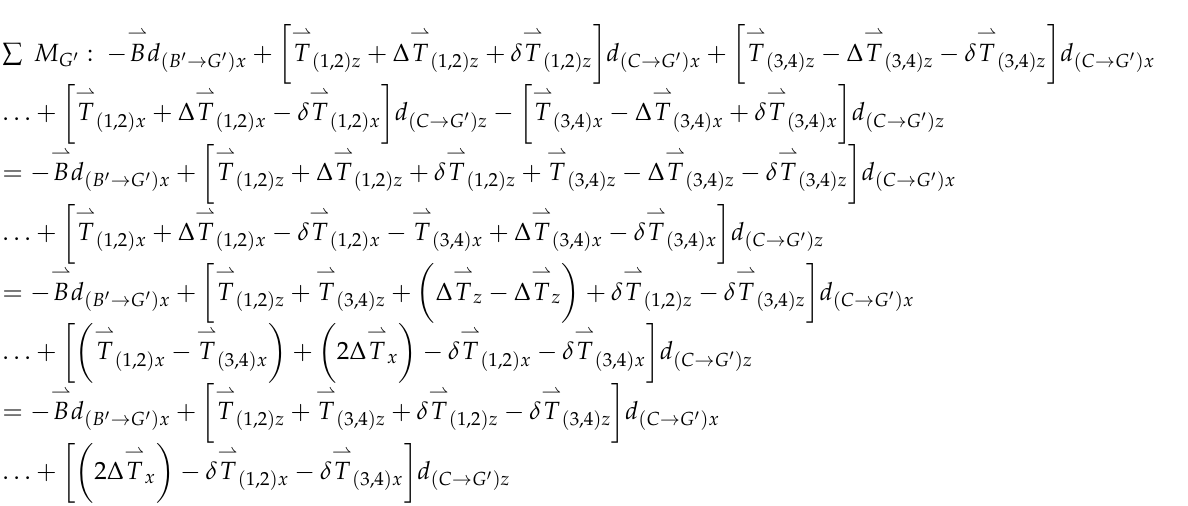
Figure 7. Case 2 ( t + ∆ t ): Balanced thrust increase (post induced